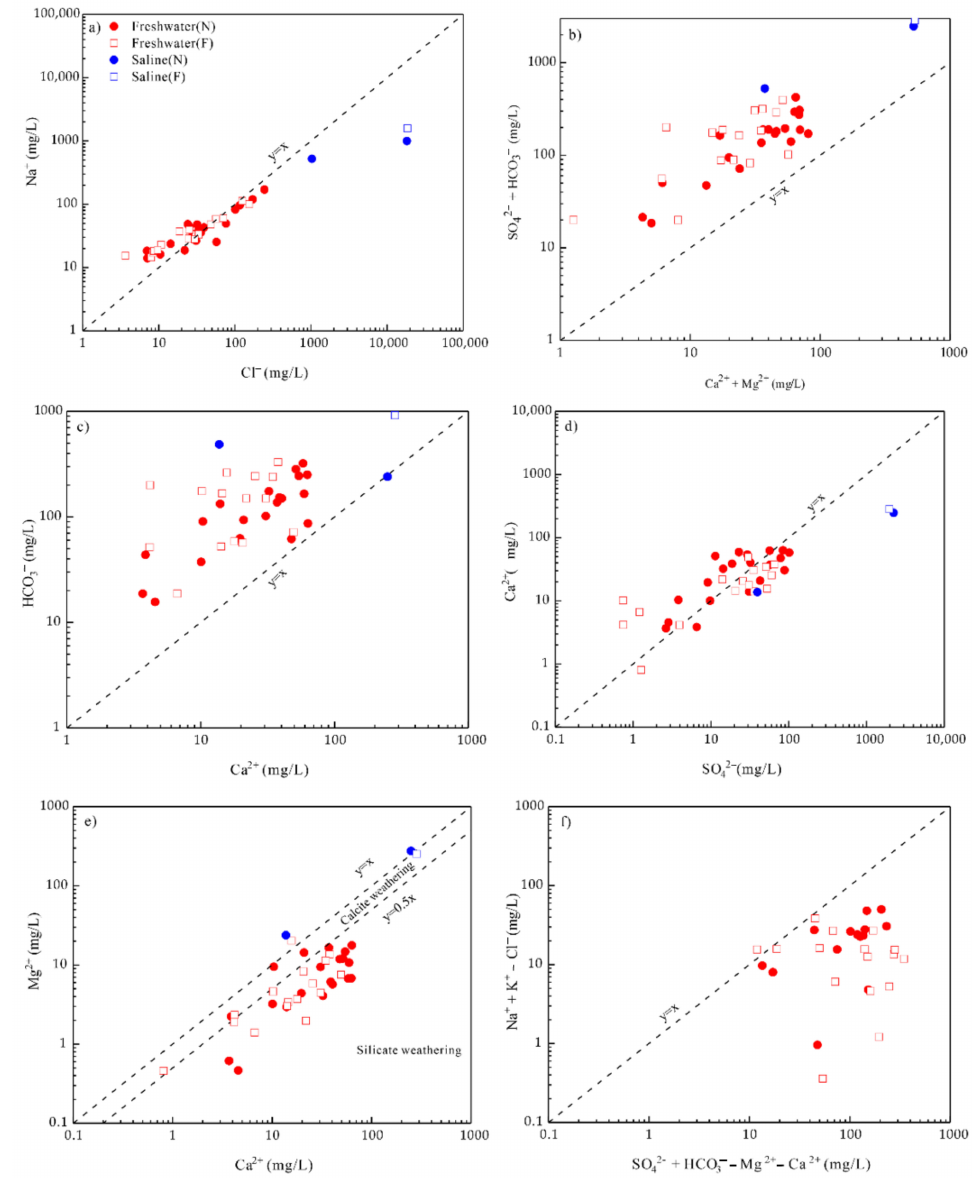
Figure 5. Plots of the relationships among significant ions in the groundwater of the coastal zone of Guangdong Province, China. ( a ) Na + versus Cl − , ( b ) SO 42 − +HCO 3 − versus Ca 2+ +Mg 2+ , ( c ) HCO 3 − versus Ca 2+ , ( d ) Ca 2+ versus SO 42 − , ( e ) Mg 2+ versus Ca 2+ , ( f ) Na + + K + − Cl − versus SO 42 − + HCO 3 − − Mg 2+ − Ca 2+ . The dotted lines represent the function “y = x”. Function “y = 0.5x” has been added to e , and between functions “y = x” and “y = 0.5x” represent Calcite weathering and the below function “y = 0.5x” represents silicate